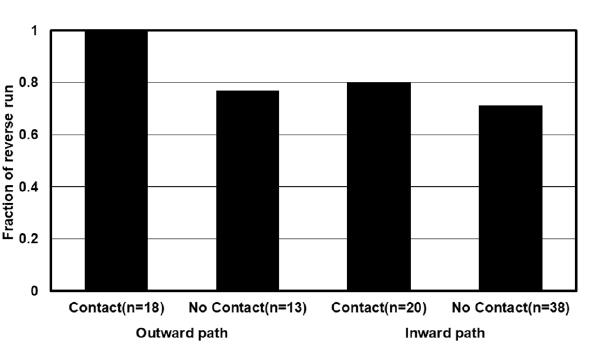
Figure 4. Influence of body contact with another foraging ant on the target ants immediately after joining the bridge. Based on the trials of the main experiment, the presence or absence of contact was examined in the outward and inward paths, and the fraction of the reverse run (goal) against the normal run (goal) with respect to contact and no contact was displayed respectively. The term n indicates the number of